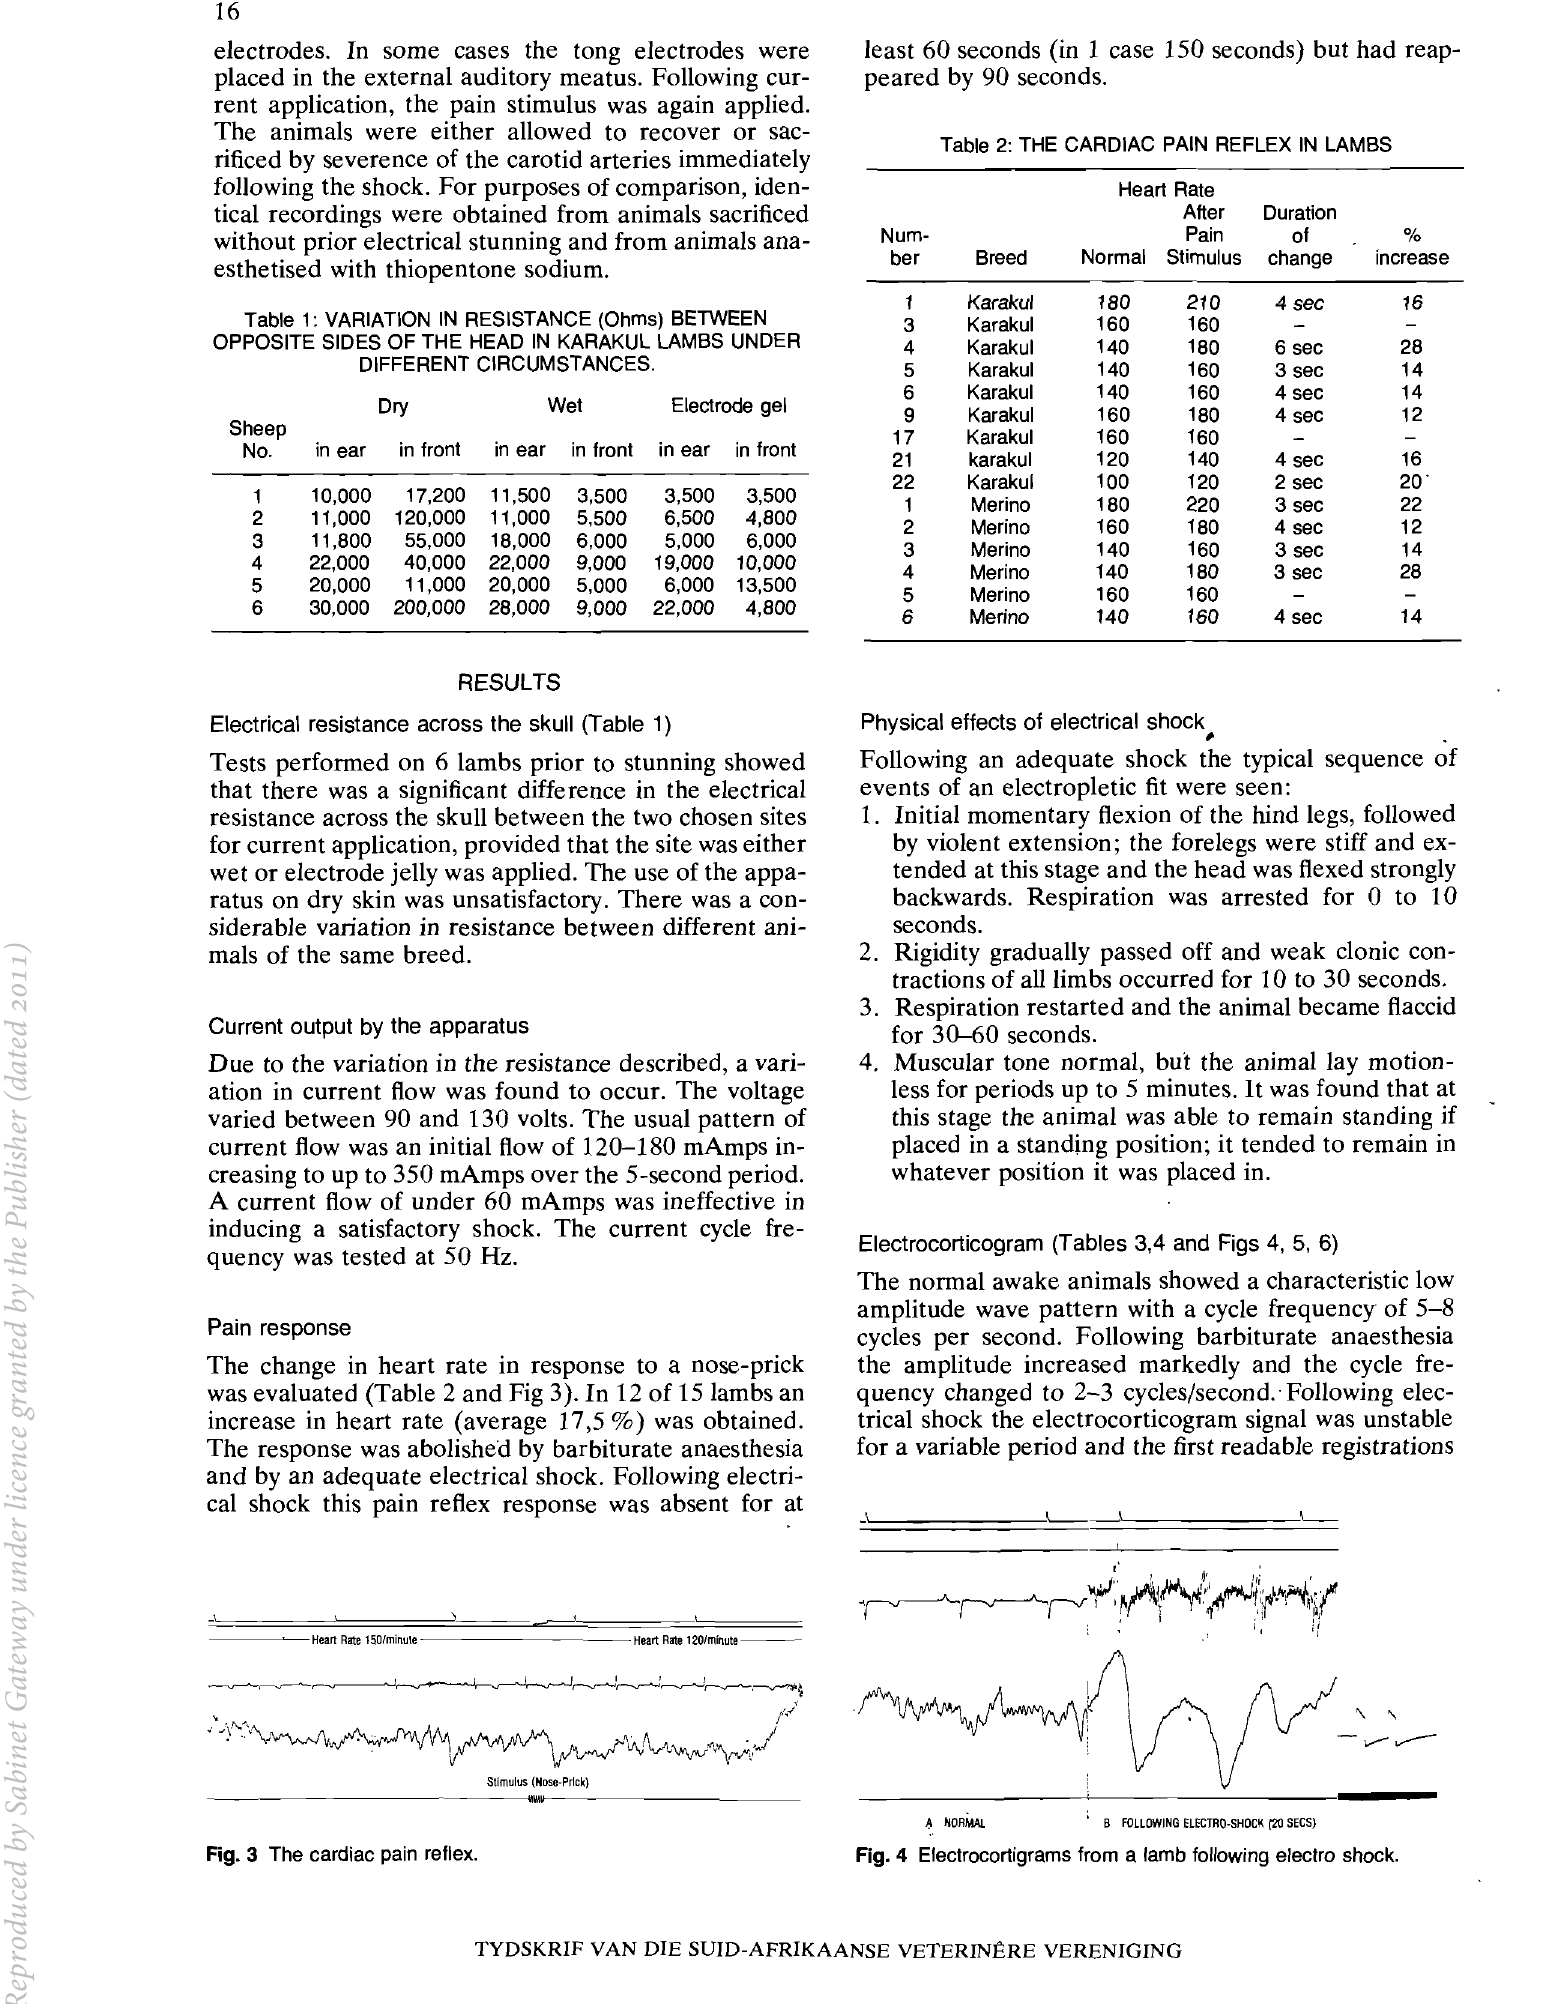
Fig. 3 The cardiac pain reflex.